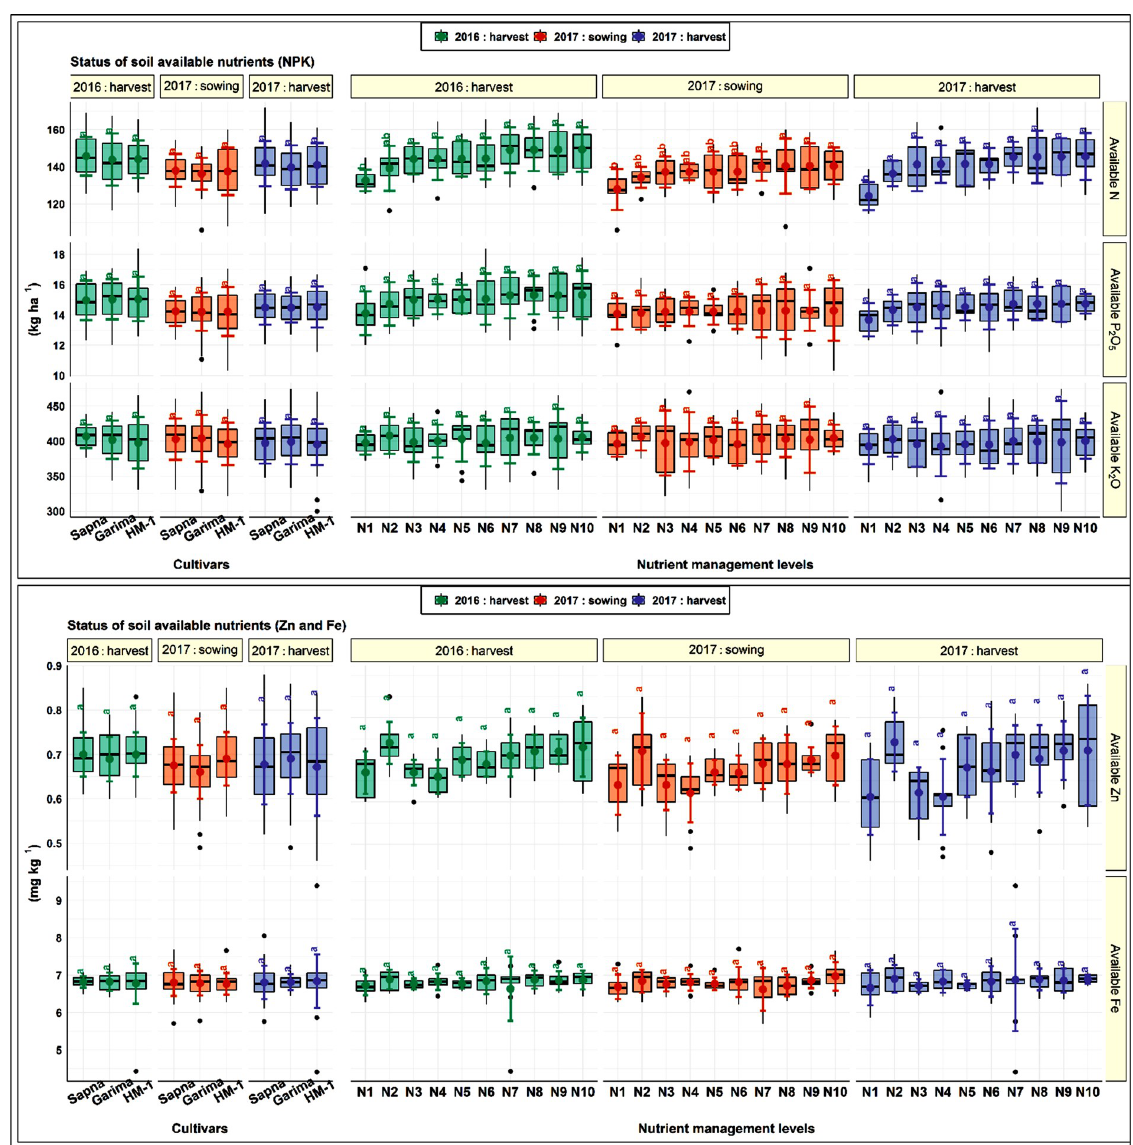
Fig 6. Status of soil available nutrients as influenced by cultivar selection and nutrient management levels. (treatments with 50% RDN) stayed in the right section of the PCA biplots. Nutrient manage- ment treatments N2, N5, N6 and N7 (treatments with 100% RDF with other combinations) were the individuals with negative loadings on PC1 and positive loadings on PC2. They stayed in the upper left section of the PCA biplots. Treatment N1 and N3 (no chemical fertilizers) stayed in different lower sections of the PCA biplot during both years. Varieties’ positions in the biplot indicate no influence of varieties on soil properties. Concerning the variables, it was noticed that pH and EC have negative loadings on PC1 and positive loadings on PC2 (upper left section of PCA biplots). In contrast, variables K and Zn showed loadings contradictory to pH and EC (lower right section of PCA biplots). Variables N, P, and Fe have positive loadings on both PCs (upper right section of PCA biplots). Furthermore, the shrinkage in the point size of individuals or the lessening length/colour intensity of the arrows of the variables signifies